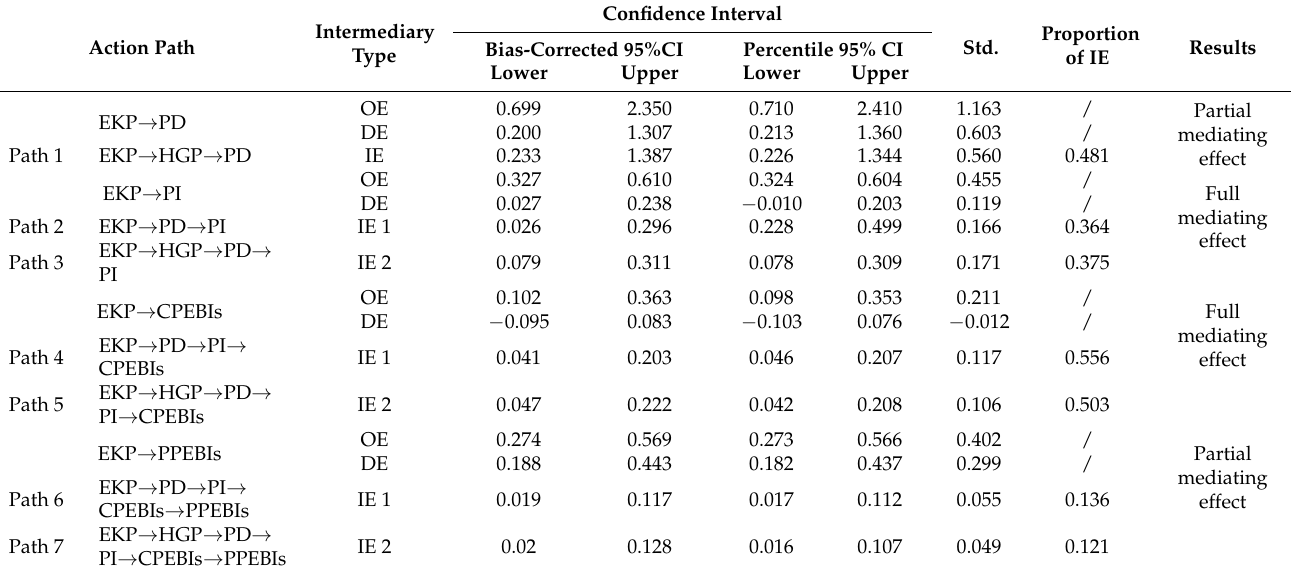
Table 8. Mediation effect